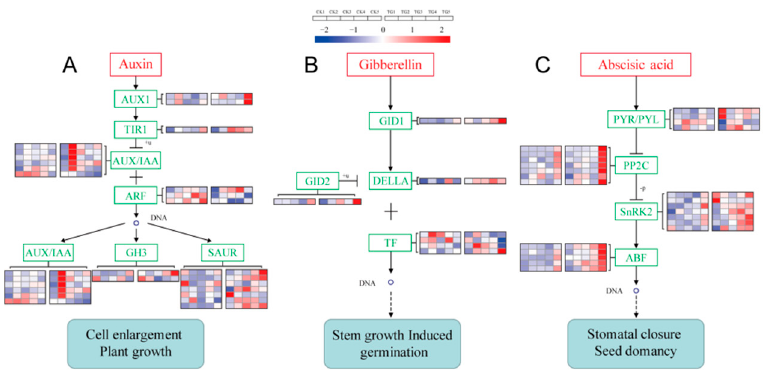
Figure 11. Signal transduction pathways and expressions of related genes. ( A ) Auxin signal transduction. ( B ) Gibberellin signal transduction. ( C ) Abscisic acid signal transduction. The FPKM values of the genes were normalized by Pheatmap package in R language before the heatmap was drawn. In the color legend on the right side of the heatmap, the color labels of each gene correspond to the bar graph on the left side of the heatmap. The experiment was repeated at least three times and the results were similar. The heatmap data are the average of the repeated FPKM values. In the heatmap, five on the left side of the heatmap box are CK1-5, and on the right side of the heatmap box are TG1-5, respectively.